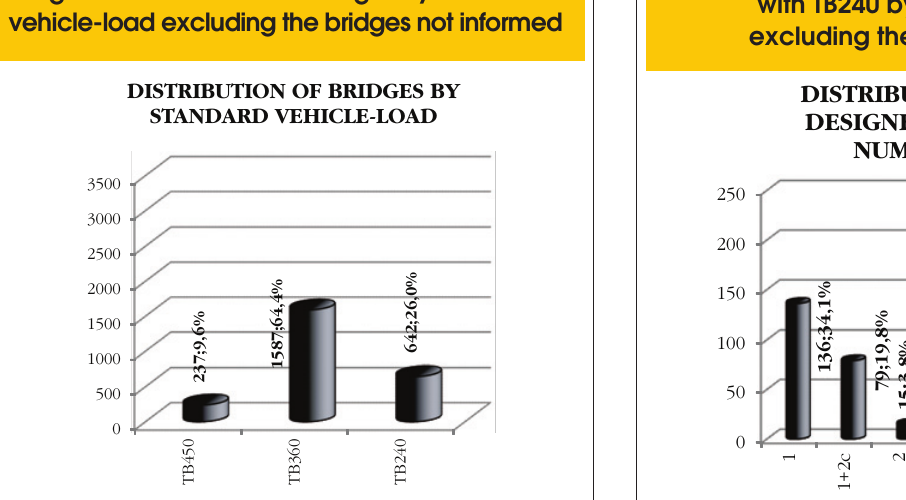
Figure 4 – Distribution of bridges designed with TB240 by number of